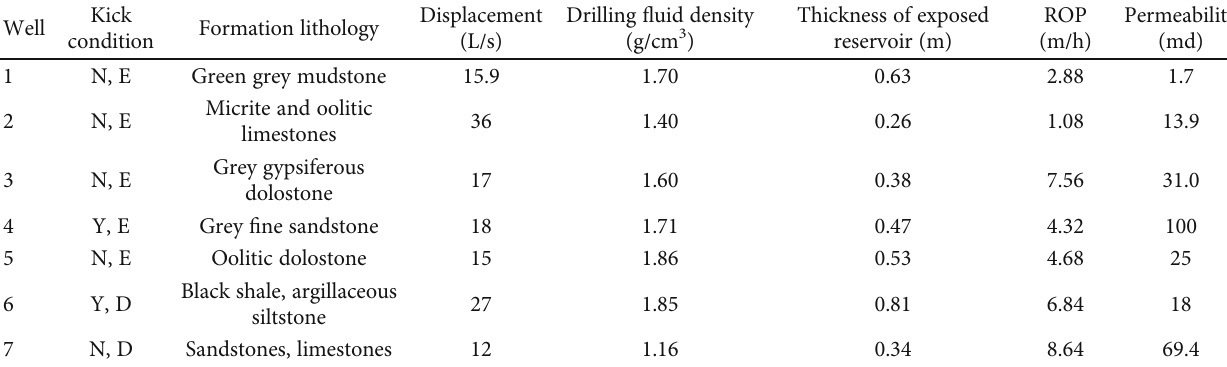
Table 3: The detailed information of the kicking